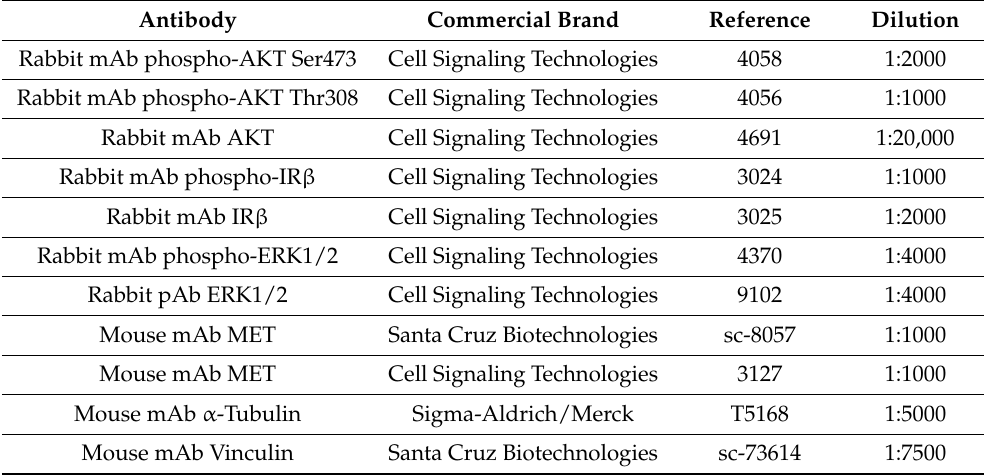
Table 1. List of primary antibodies. Antibodies were diluted in TTBS supplemented with 0.4% BSA at the indicated